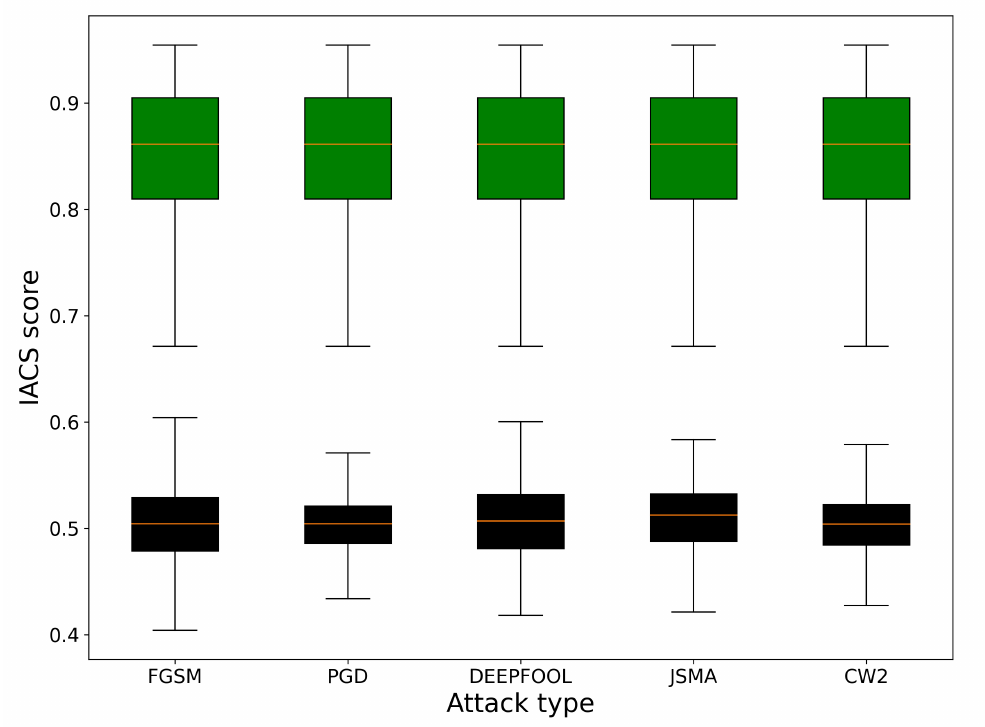
Figure 4. Crossing attacks performance: The horizontal axis represents the training set, and the verti- cal axis represents the test set. The closer the color is to yellow, the better the detector’s performance is (DP refers to DeepFool).